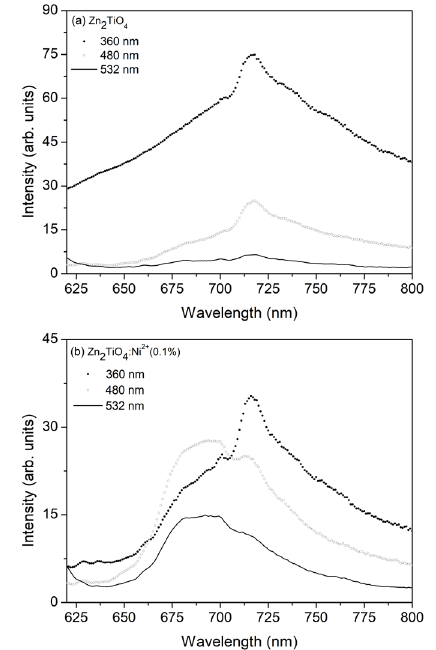
Figure 6. Room temperature time-resolved emission spectra of (a) Zn TiO and (b) Zn TiO :Ni 2+ (0.1% of Ni 2+ ), both with a lamp 2 4 2 4 repetition rate of 200 Hz, obtained with excitation wavelengths of 360 nm, 480 nm, and 532 nm.